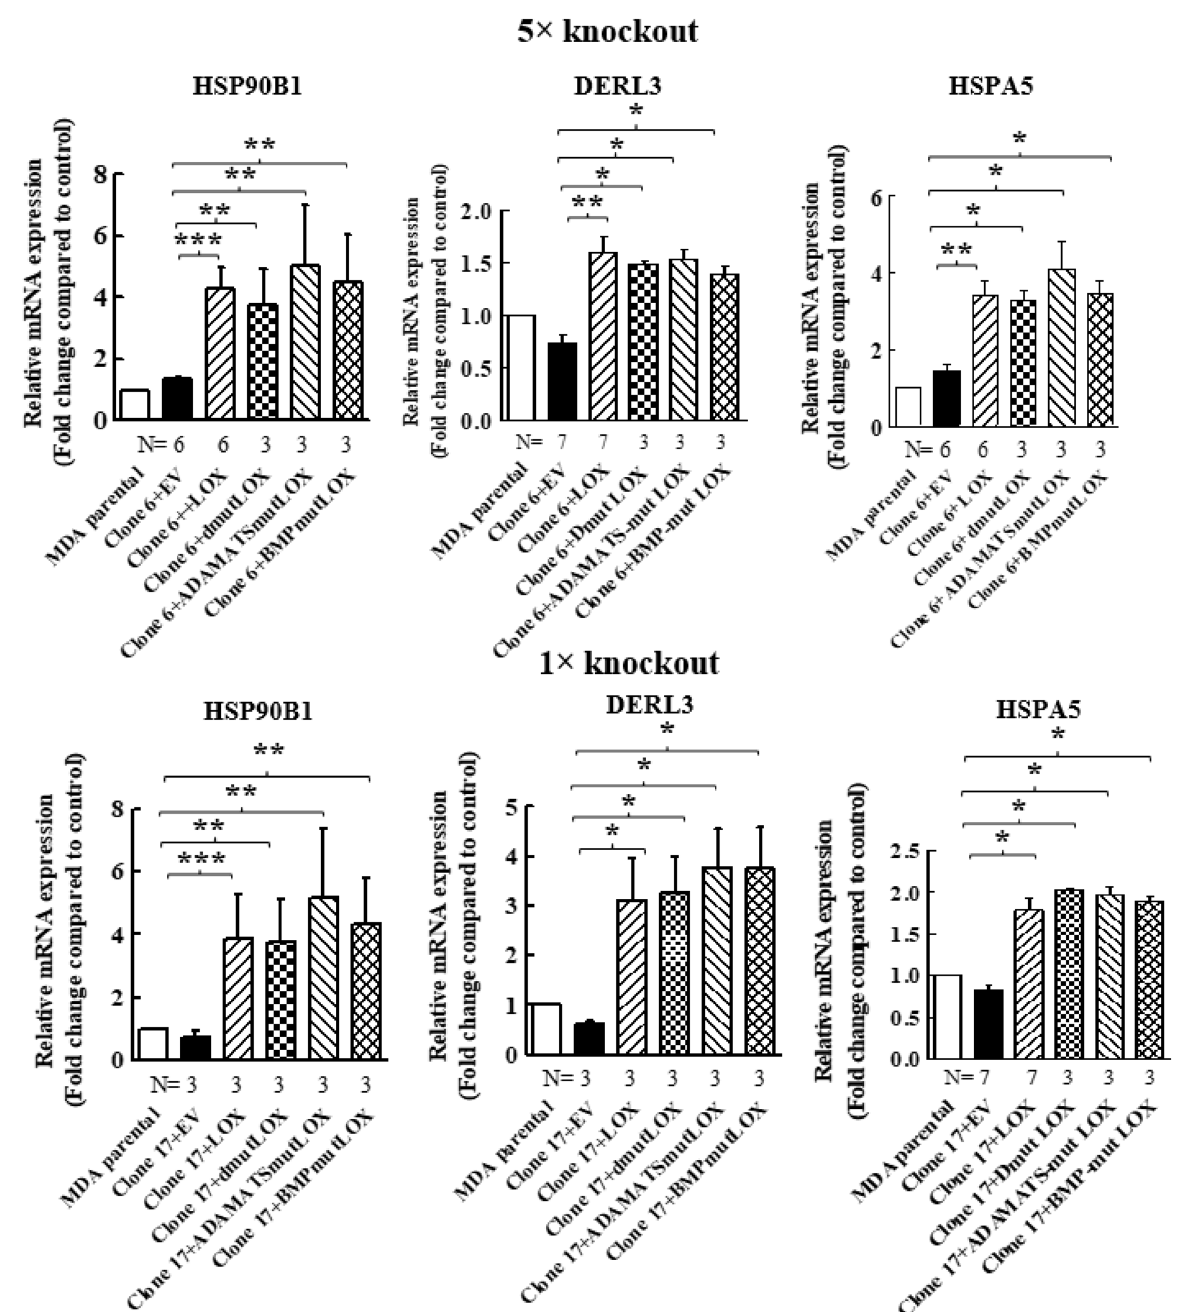
Figure 7. Point-mutated LOX variants that fail to be cleaved are still able to promote the expres- sion of LOX-regulated genes. The expression levels of the STOX2, AGR2, DNAJB11 and DNAJC3 mRNA were determined in MB-MDA-231 as well as in 5× and 1× knock-out cells using qRT-PCR. The expression was compared with the expression level of these genes following the expression of the indicated LOX variants. Results were normalized with the expression level in MB-MDA-231 parental cells. Data represent the mean ± SEM of N independent experiments. Statistical signifi- unsuspected biological functions that do not require processing by the ADAMTS2/14 or BMP-1 proteases at the classical cleavage sites of LOX.